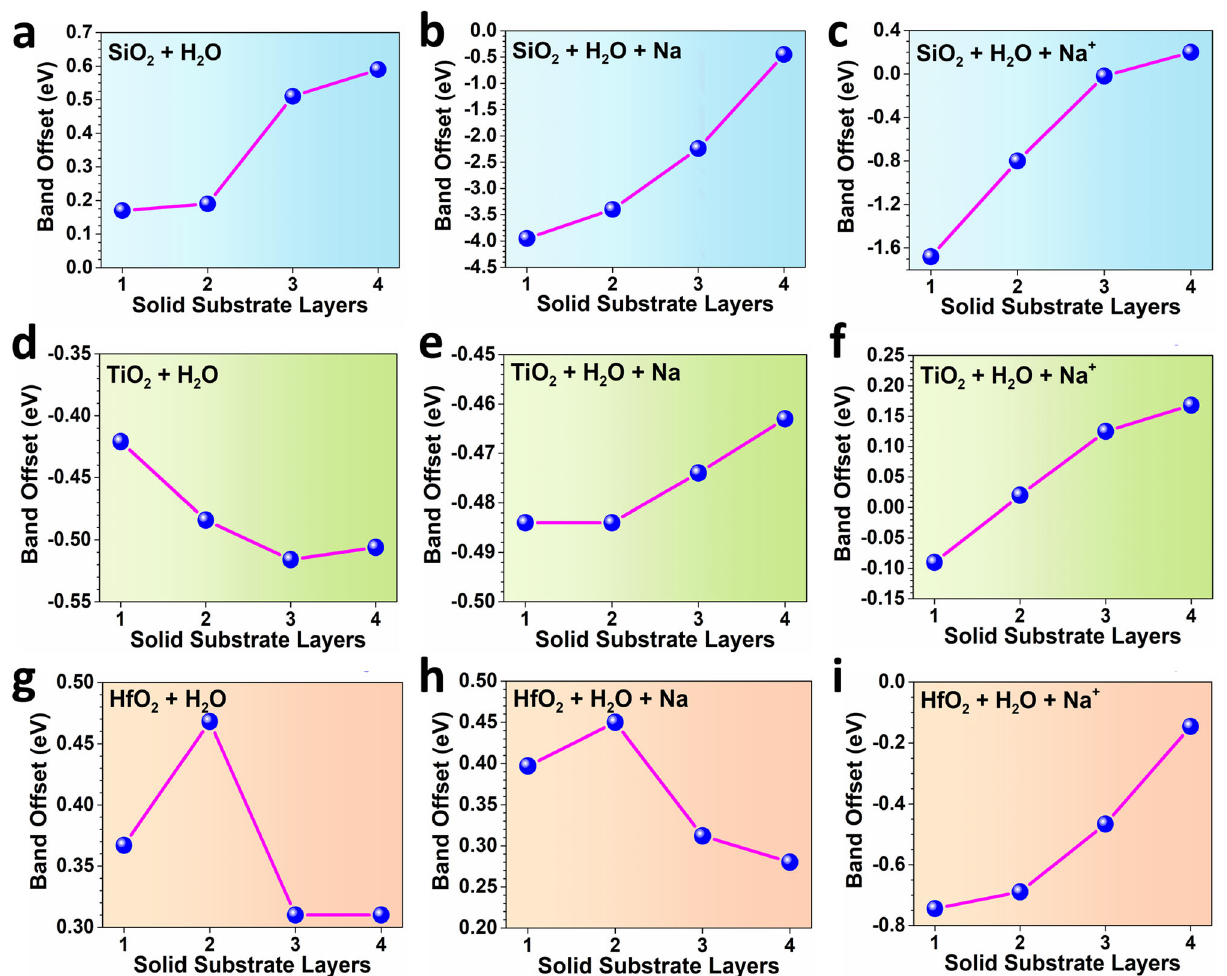
Fig. 3 The band offset variations for different layers of liquid – solid systems. a SiO 2 + H 2 O. b SiO 2 + H 2 O + Na. c SiO 2 + H 2 O + Na + . d TiO 2 + H 2 O. e TiO 2 + H 2 O + Na. f TiO 2 + H 2 O + Na + . g HfO 2 + H 2 O. h HfO 2 + H 2 O + Na. i HfO2 + H 2 O + Na +